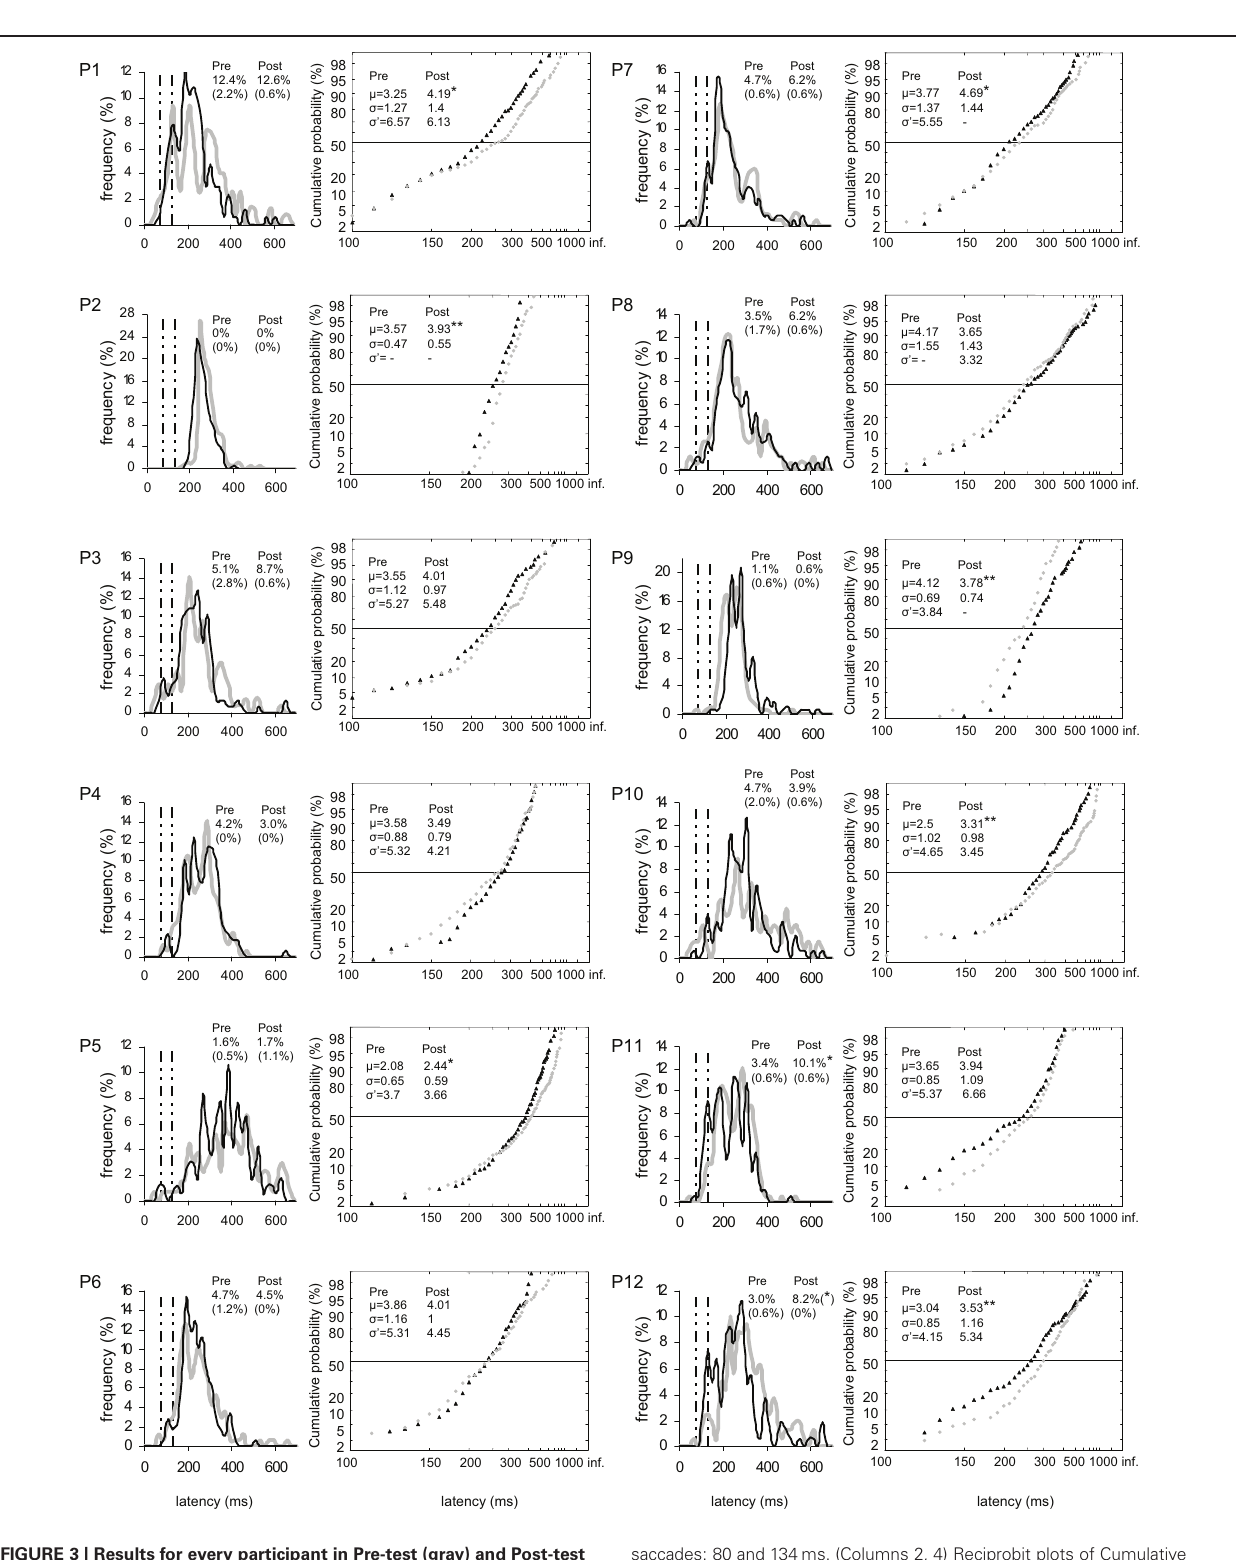
FIGURE 3 | Results for every participant in Pre-test (gray) and Post-test (black) periods for both targets. (Columns 1, 3) Histograms of Frequency (in %) as a function of Latency (in ms) for saccades between 0 and 999ms in valid direction, and rates of express (Exp) and of anticipatory (Ant) saccades. Bin width is 20ms. Vertical semi-dotted lines indicate the limits of express